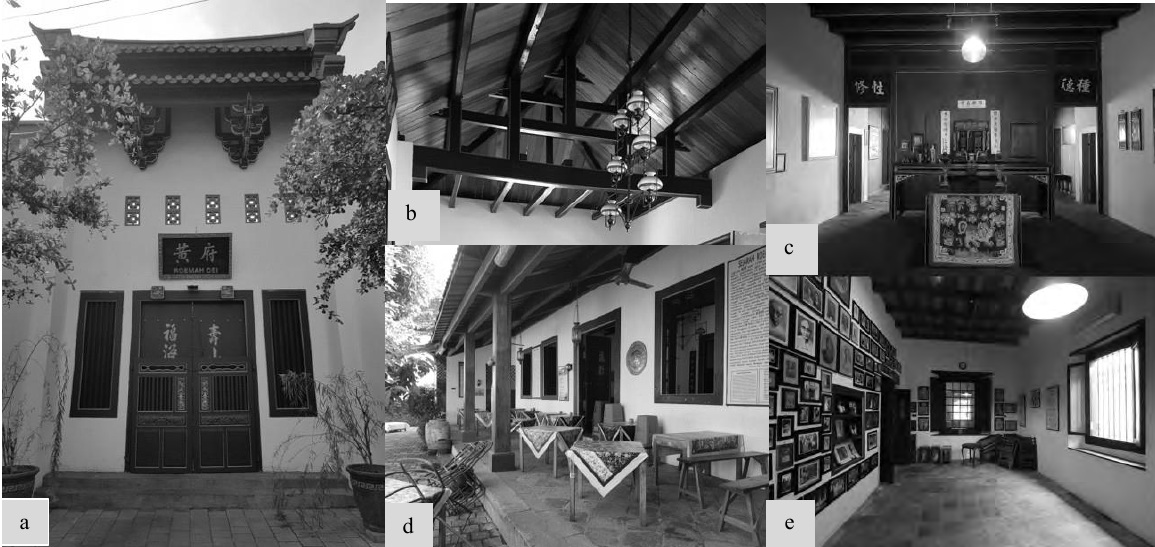
Figure 3. The transformation of the Oei House: (A) the site plan of the existing condition, (B) the floor plan of the existing condition, and (C) the floor plan of the original condition